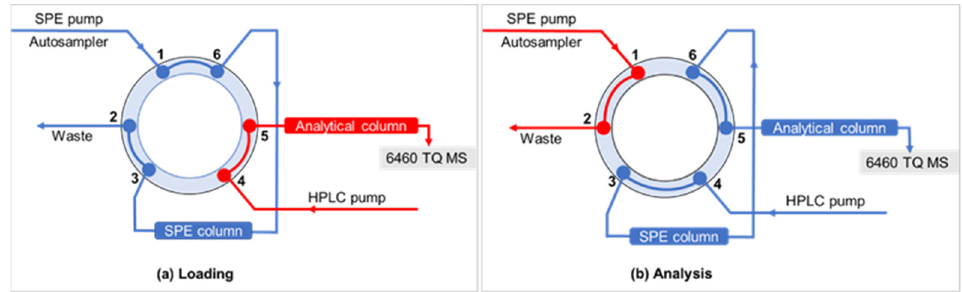
Figure 1. Configuration of the online SPE and the six-port switching valve.